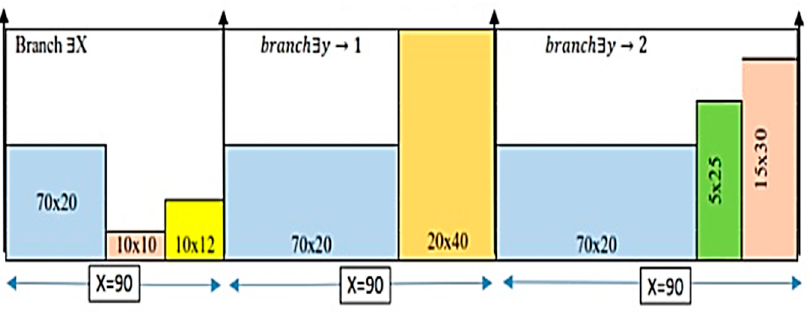
10.6.3.1.1.1. 𝑤 (cid:2869)((cid:2869)) {𝑏 (cid:2869) . 𝑏 (cid:2871) }𝑎𝑛𝑑 𝑤 (cid:2870) {𝑏 (cid:2869)(cid:2868) . 𝑏 (cid:2877) . 𝑏 (cid:2876) . 𝑏 (cid:2875) } . 10.6.3.2. Select the maximum 𝑿 𝒂𝒗𝒊(𝟐(cid:2879)𝟐) ≤ 𝒙 𝒃𝒊 = 𝟕𝟎 and create the next sub- matrix 𝒘 𝒌(cid:2880)𝟐 after disposing of all stowed boxes in the selected case. Stowed boxes were 𝒃 𝟏 . 𝒃 𝟓 . 𝒃 𝟔 , as illustrated in (Figure 8).